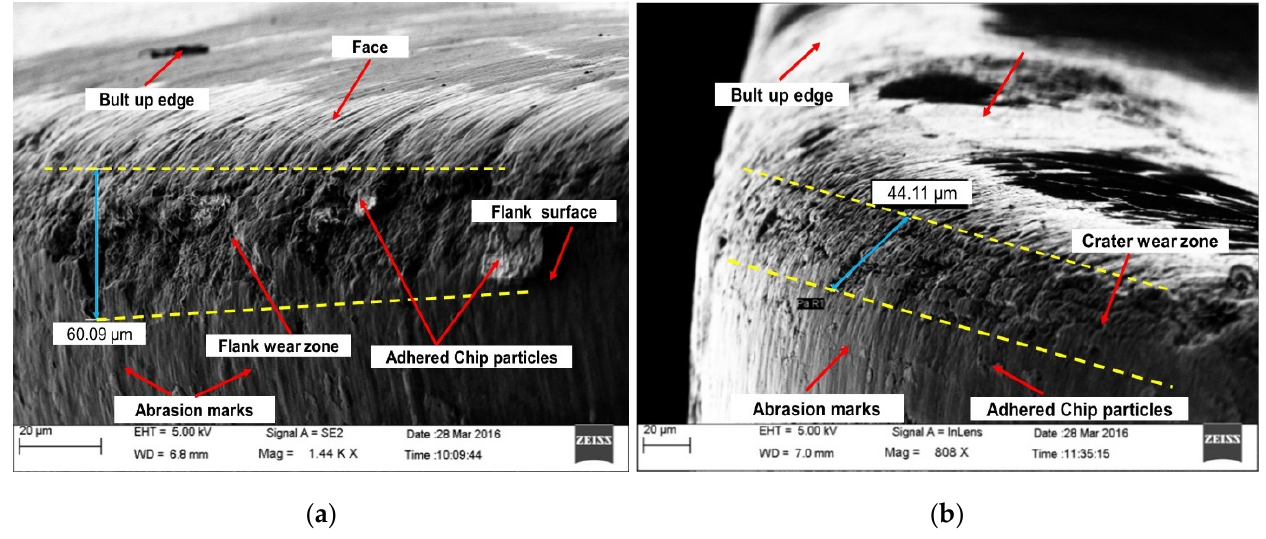
Figure 8. SEM images of a worn-out insert illustrating: ( a ) flank wear, ( b ) crater wear.